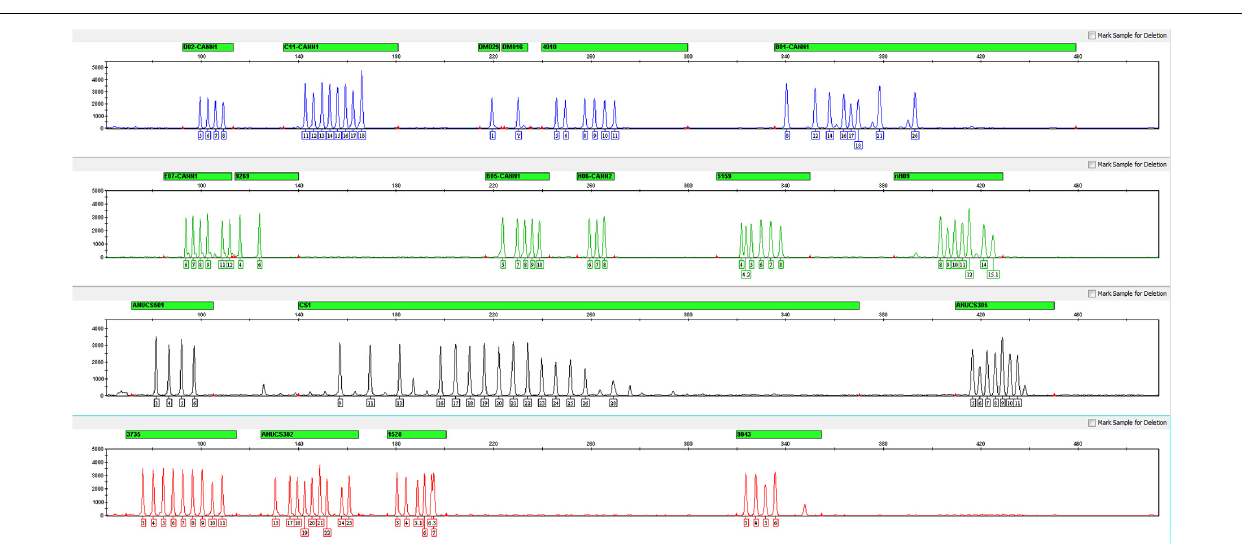
FIGURE 2 | Electropherogram of the allelic ladder designed for the Cannabis sativa 19-plex typing